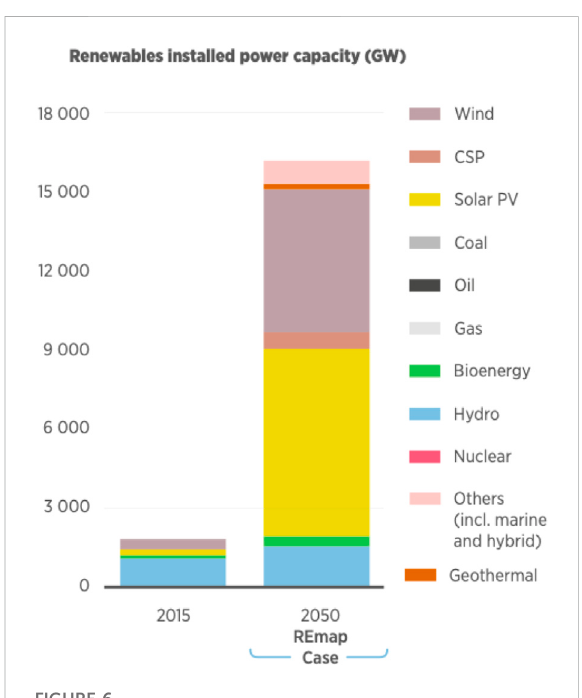
FIGURE 6 Energy resources installed in 2015 versus 2050 (Taibi et al.,